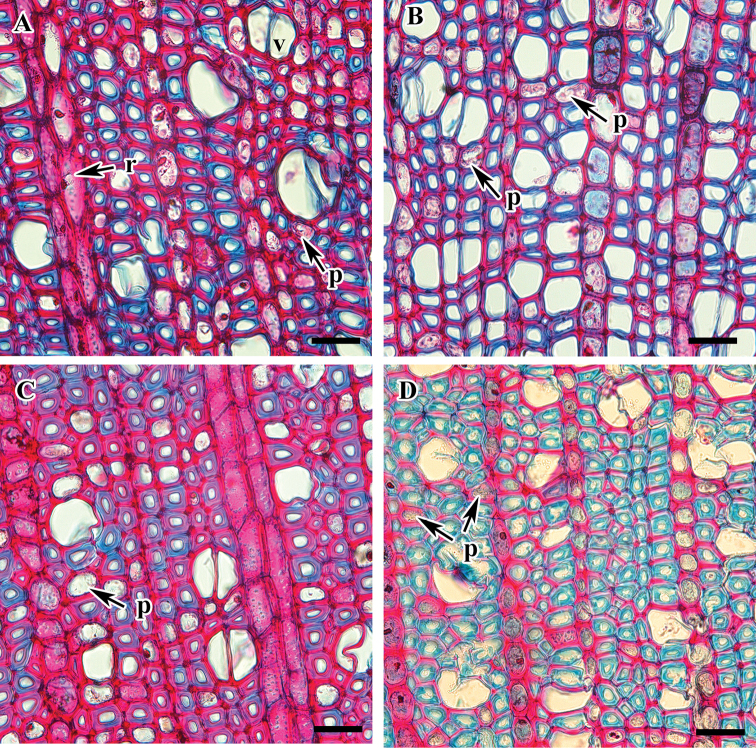
Cross section of Viburnum species showing axial parenchyma (magnified). AV.
japonicumBV.
ordoratissimum
var.
awabukiCV.
wrightiiDV.
furcatum. Abbreviations: p, parenchyma cell; r, ray. Scale bars: 20 µm.